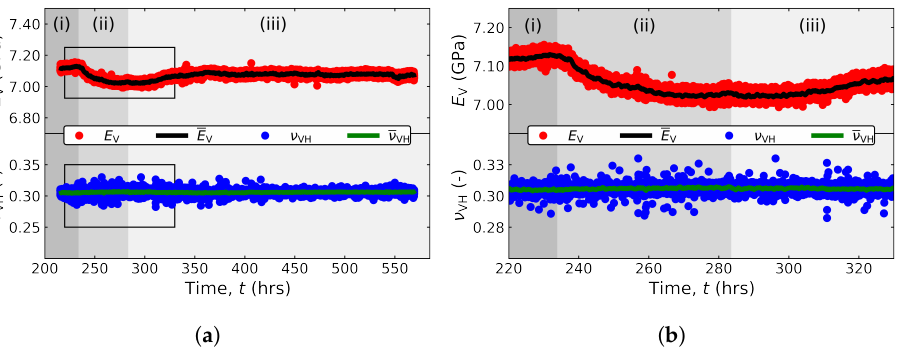
Figure 8. FO measured Young’s modulus ( E V and its averaged namesake E V ) and Poisson’s ratio ( ν VH and its averaged namesake ν VH ) versus time t at 25 Hz. Roman numbering combined with the grayscale background indicates the respective phases of fluid exposure: Phase (i), Phase (ii), and Phase (iii). Rectangles in ( a ) indicate x- and y-limits in ( b ). Fifty measurements were